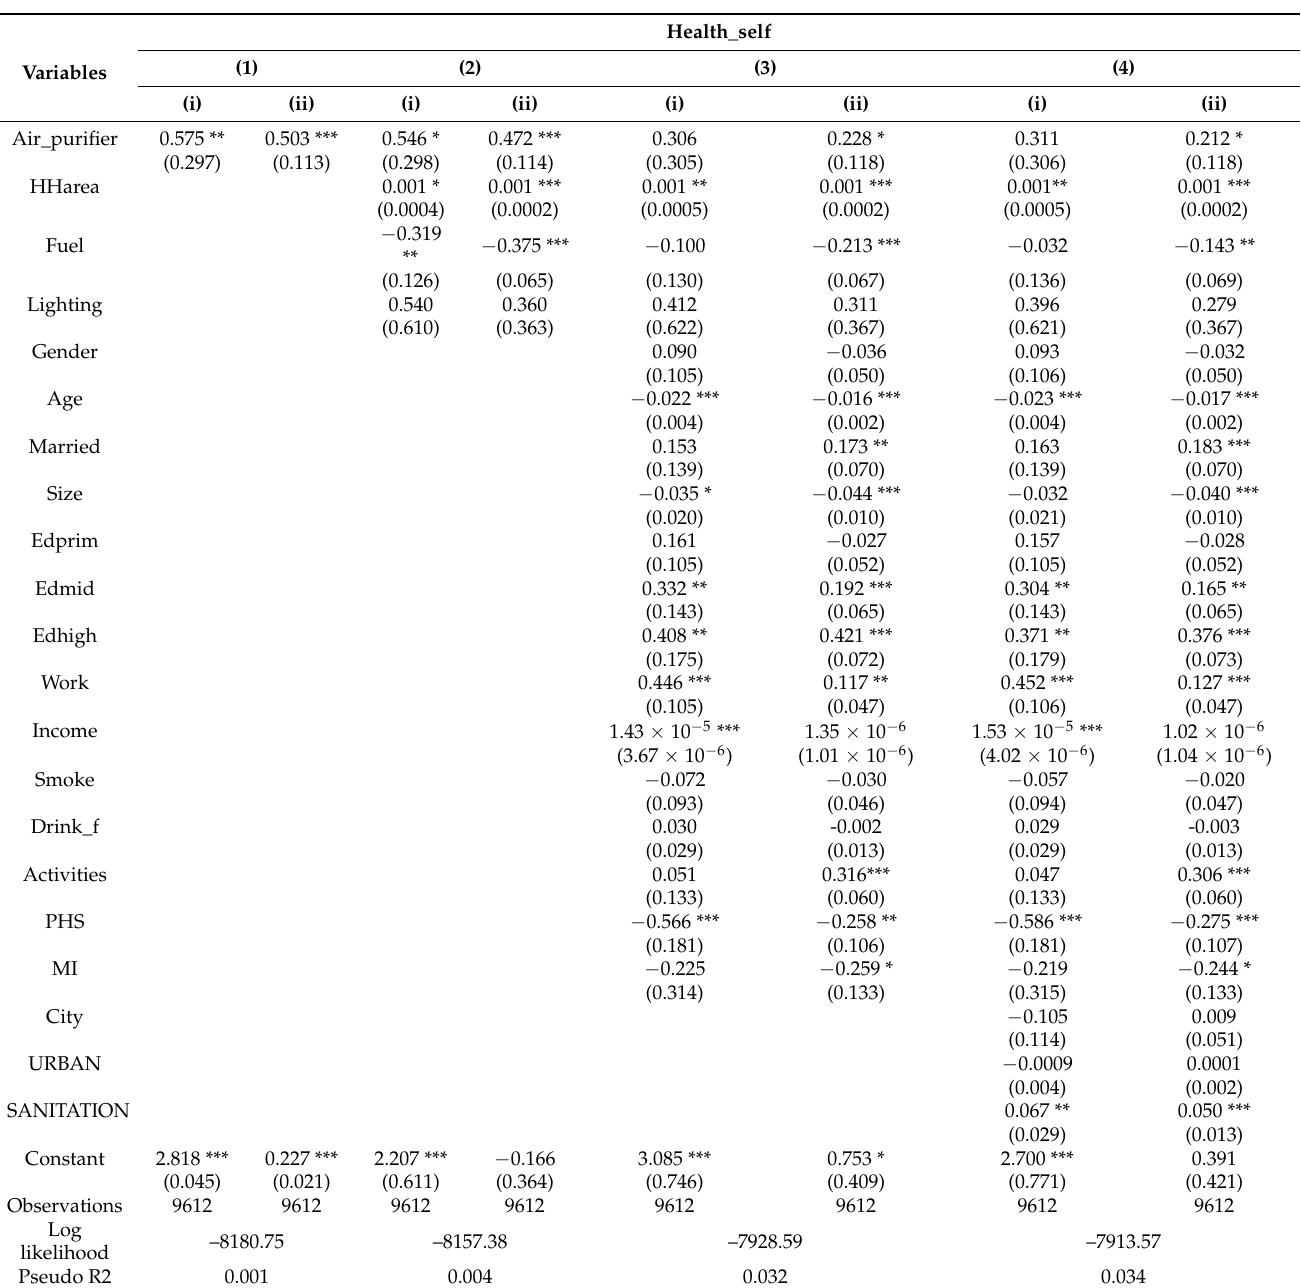
Table 3. Regression results of the effect of indoor air purification on residents’ self-rated health based on the generalized ordinal logit